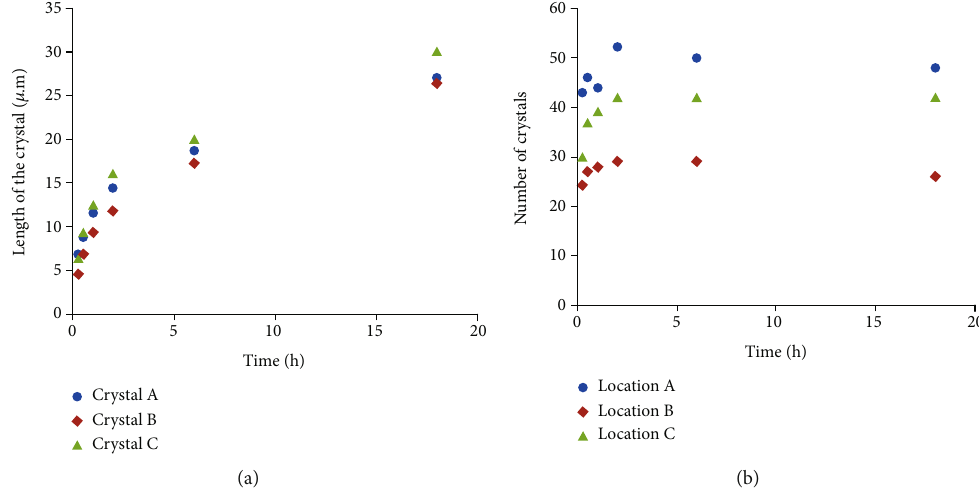
Figure 5: Growth of crystals in a micro fl uidic porous chip. (a) Length of Crystals A, B and C (as circled in Figure 4) over time; (b) Number of crystals over time at Locations A, B and C (the length of crystals is the length of the projection of the crystals in the horizontal